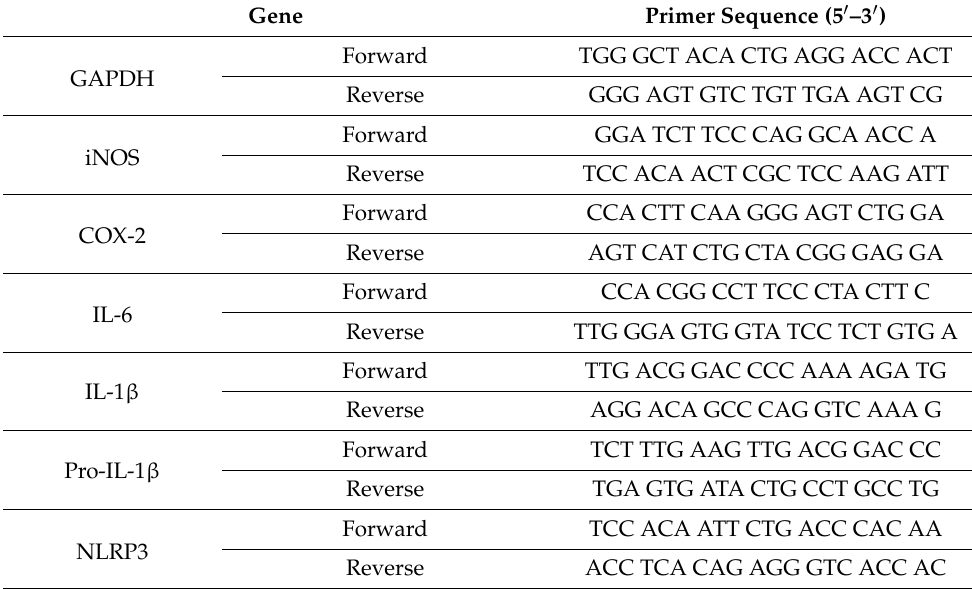
Table 2. Primer sequences of primers used for q-PCR. Gene Primer Sequence (5 (cid:48) –3 (cid:48)